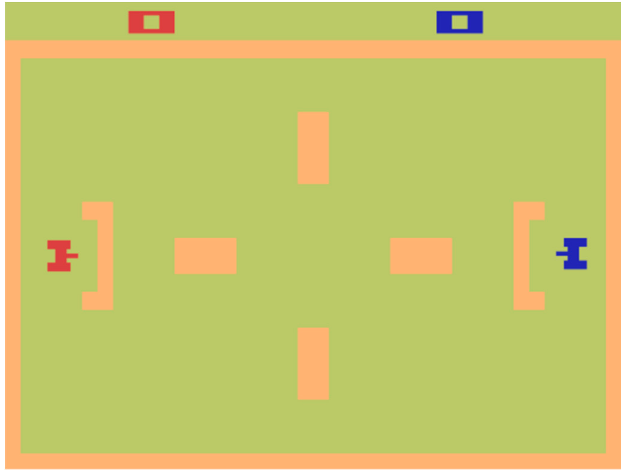
Figure 1. Atari’s Combat (1977).